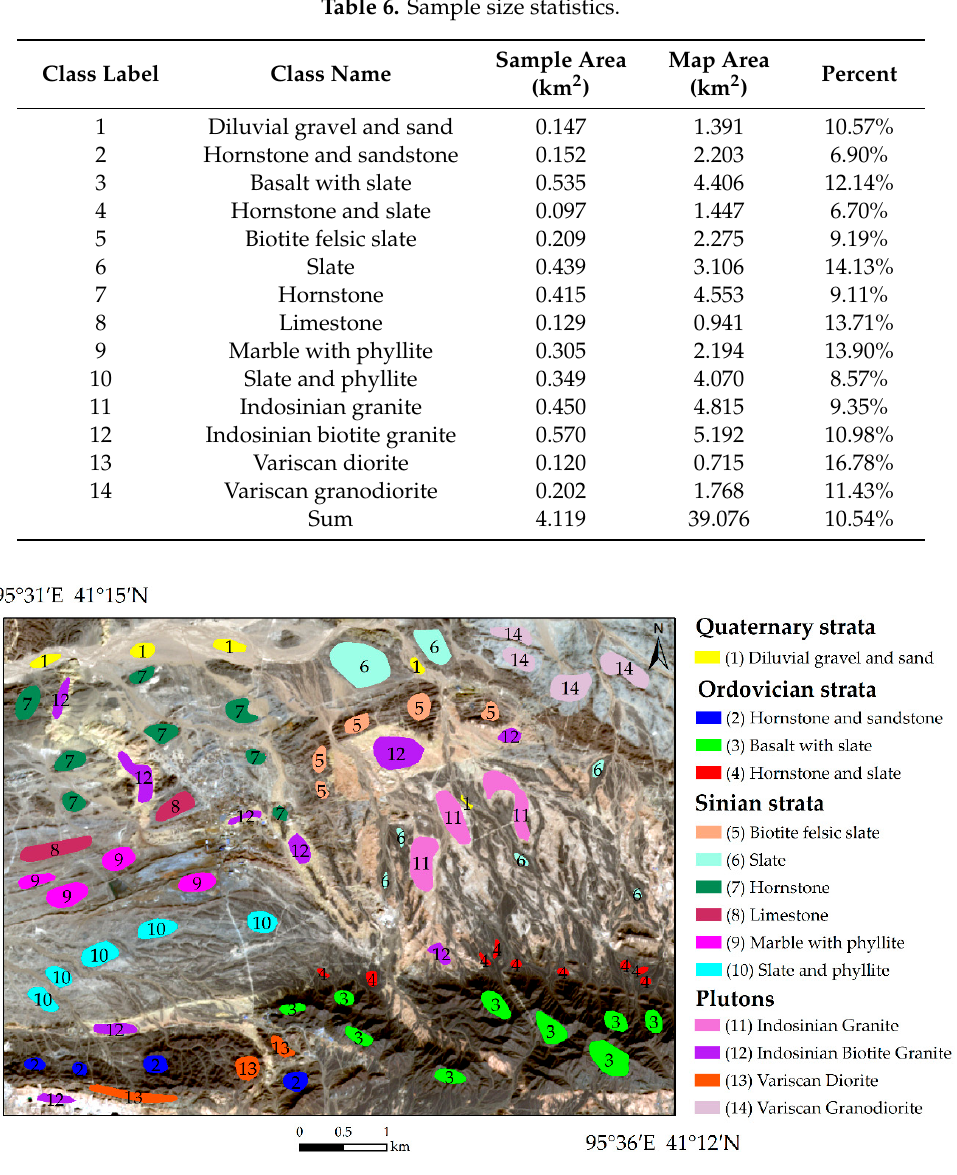
Figure 4. Sample distribution map. The numbers in Sentinel ‐ 2A imagery (R: Band 4; G: Band 3; B: Band 2) and on the left side of legend represent the class numbers. Table 7. Parameter settings of different models.